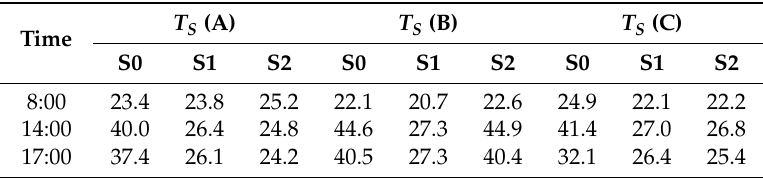
Table 4. Principal surface temperature values in point A, B and C for scenarios S0 (initial